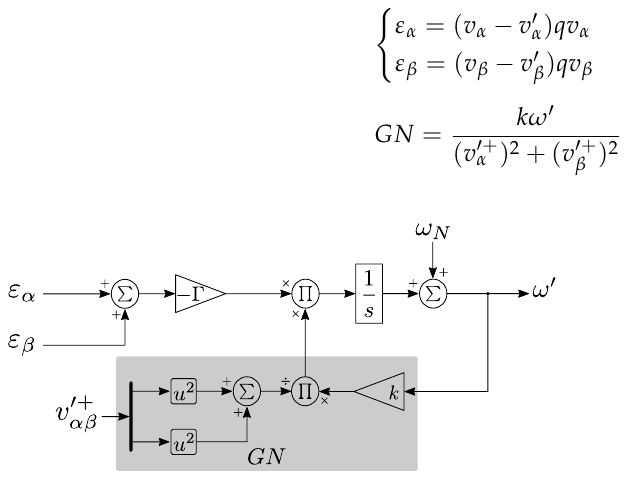
Figure 8. FLL block